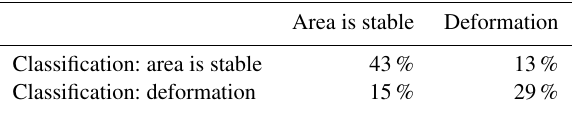
Table 4. Confusion matrix for the classification of the rockfall area. Area is